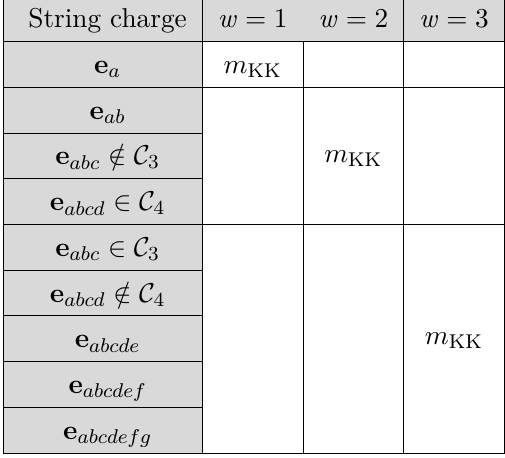
Behavior of m ∗ in comparison with the string tension.